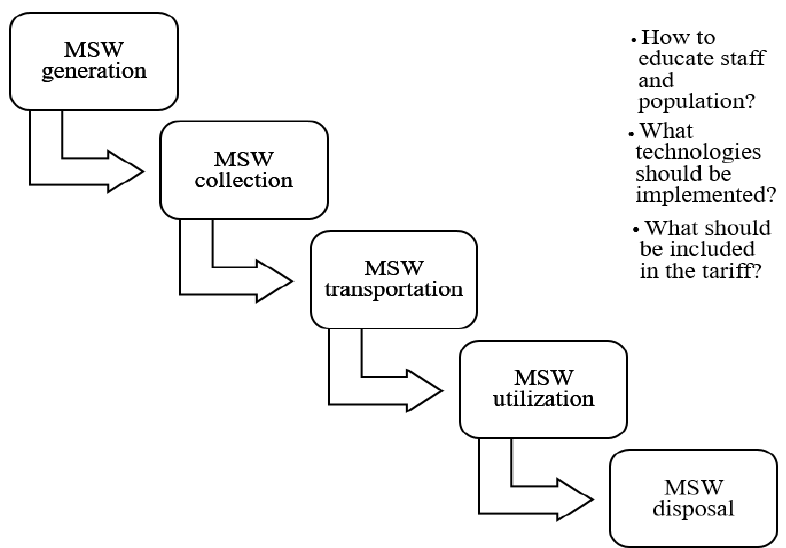
Figure 4. Stages of MSW handling process and main questions in the course of reform.